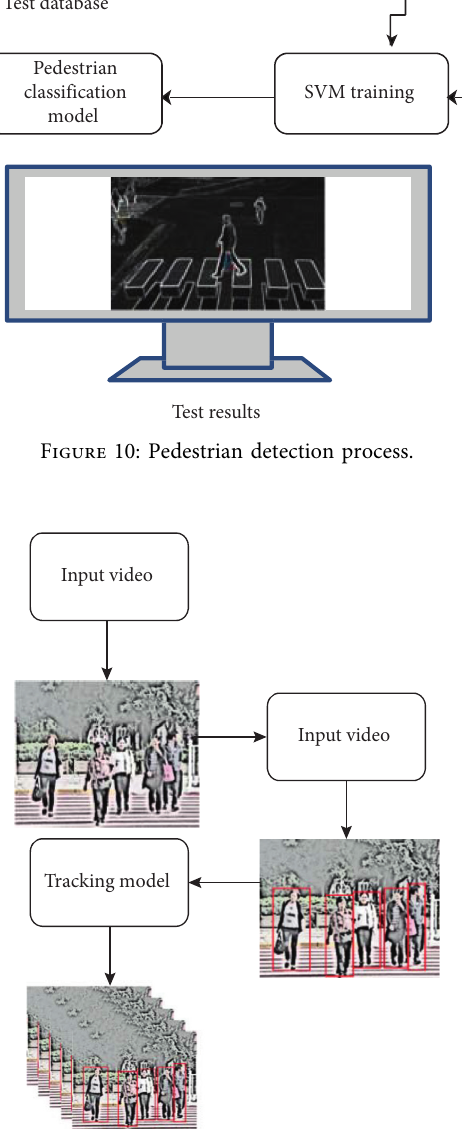
Figure 11: Pedestrian detection and multitarget tracking loop